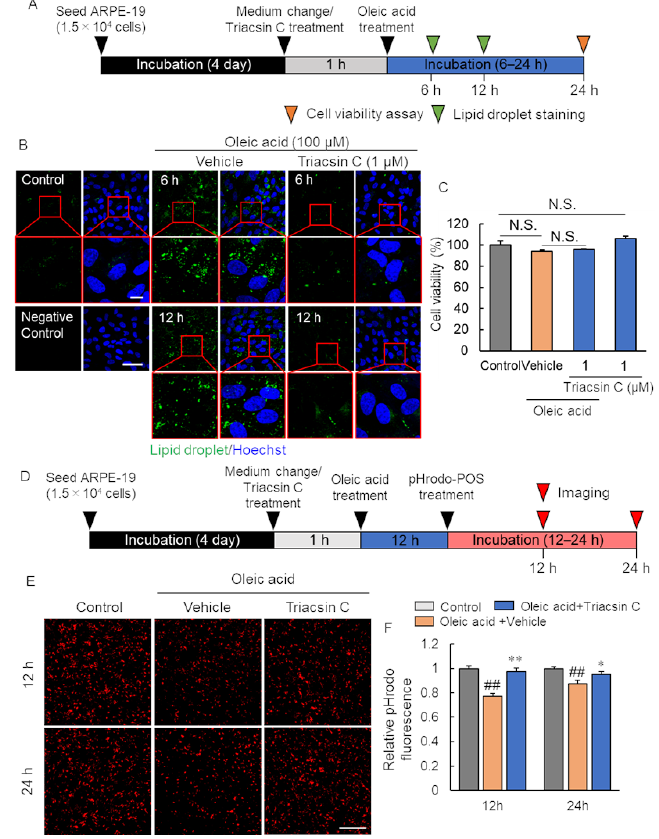
Figure 4. Improvement in phagocytosis by inhibition of lipid droplet accumulation. ( A ) Experimental protocol. Green arrow heads show lipid droplet staining timepoint (6 and 12 h after oleic acid treatment), and orange arrow head shows cell viability assay timepoint (24 h after oleic acid treatment). ( B ) The representative image of lipid droplet (green) and Hoechst 33342 (blue) following triacsin C and oleic acid treatment. Scale bar shows 10 µ m (magnified image) or 50 µ m. ( C ) The quantitative data of cell viability after triacsin C and oleic acid treatment. ( D ) Experimental protocol of phagocytosis assay after triacsin C and oleic acid treatment. Red arrow heads show the imaging timepoint (12 and 24 h after pHrodo-POS treatment). ( E ) The representative image of phagocyted pHrodo- POS in ARPE-19 cells after triacsin C and oleic acid treatment. Scale bar shows 100 µ m. ( F ) The quantitative data of the pHrodo fluorescence intensity. Data are the means ± SEMs ( n = 6 independent experiments). ## p < 0.01 vs. control, ** p < 0.01, * p < 0.05 vs. Oleic acid + vehicle (Tukey’s test). N.S.—No significant